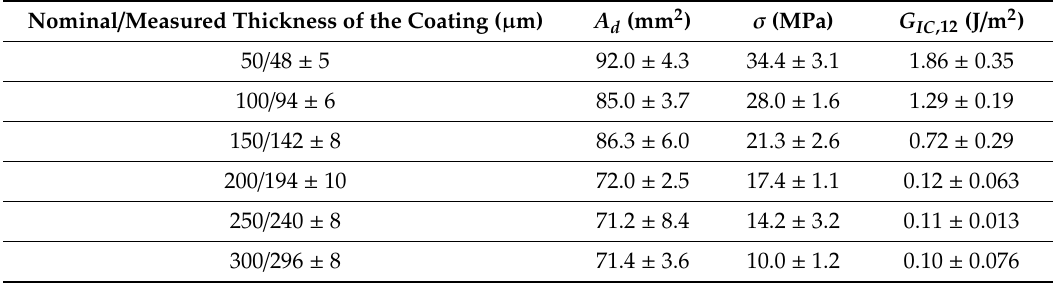
Figure 4. Relationship between bonding strength and coating thickness (blue points: experimental values, dashed line: fitting curve).